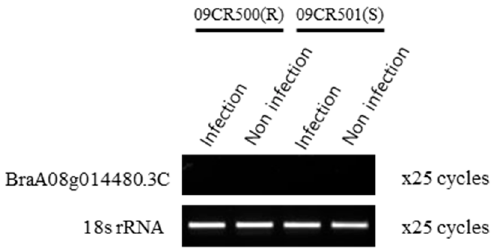
Figure 4. Expression analysis of the Crr1a candidate gene to validate that PbBrA08 Banglim of resistant line “09CR500” is not same allele. Semiquantitative RT-PCR was done in resistant line “09CR500” and susceptible line “09CR501”. “Infection” refers to the treatment of pathotype “Banglim” to plants, and “Non infection“ indicates that no treatment has been performed. The B. rapa 18s rRNA was used as a control. PCR cycles are indicated on the right side. The candidate gene of Crr1a was not expressed in “09CR500” and “09CR501” in both conditions such as before and after infection.